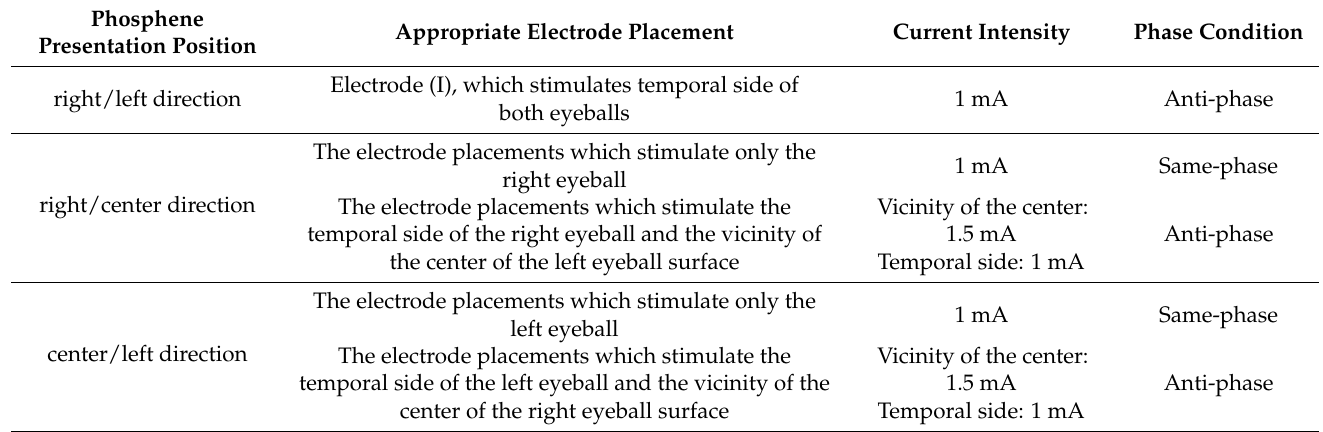
Table 6. The methods to present the phosphene in two directions in the visual